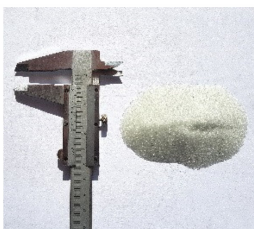
Figure 3. Fine-grained abrasive fraction to improve the hydraulic parameters of the